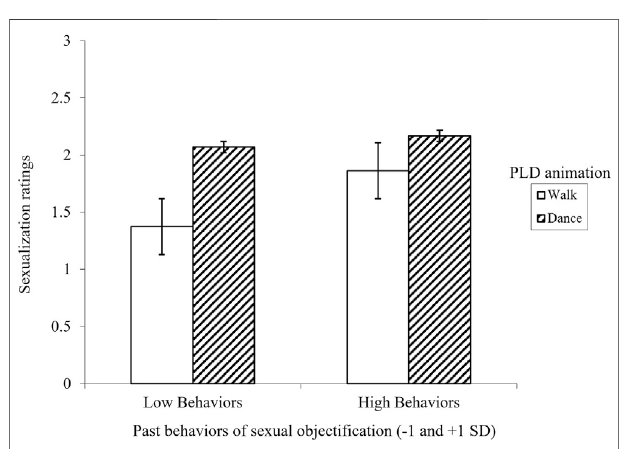
FIGURE 5 | Sexualization ratings (with 95% con fi dence interval) for low andhighpastbehaviorsofsexualobjecti fi cationbyPLDmovementanimation.